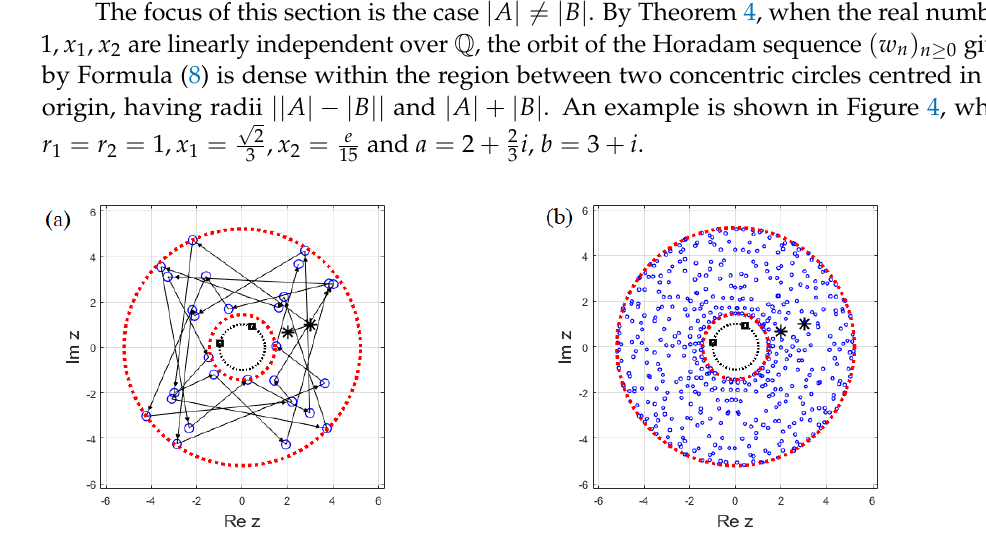
Figure 4. The case | A | (cid:54) = | B | . Horadam sequence terms ( w n ) N for ( a ) N = 30 and ( b ) N = 500. We also plot the seeds a , b (stars), generators z 1 , z 2 (squares), unit circle S (solid line), and the boundaries of the annulus U ( 0; || A | − | B || , | A | + | B | ) (dotted line). In Figure ( a ), the arrows indicate the increase in the index n .